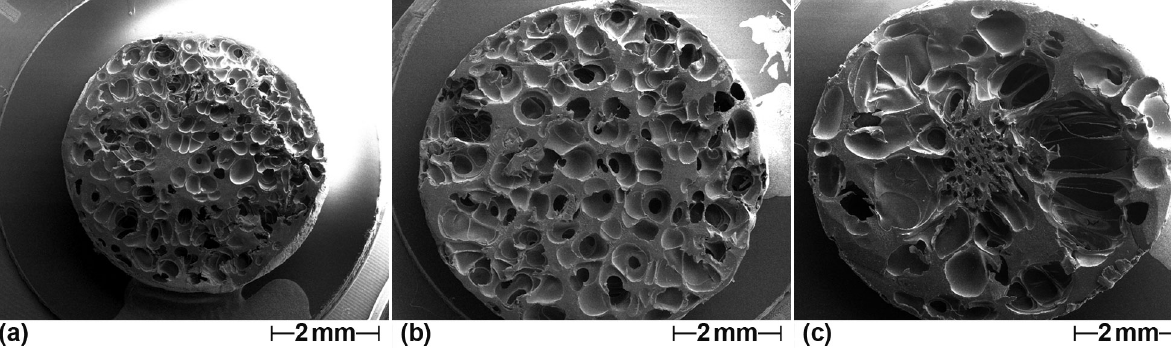
/ d of extrusion foamed CA strands using 1% Unicell TS at f p